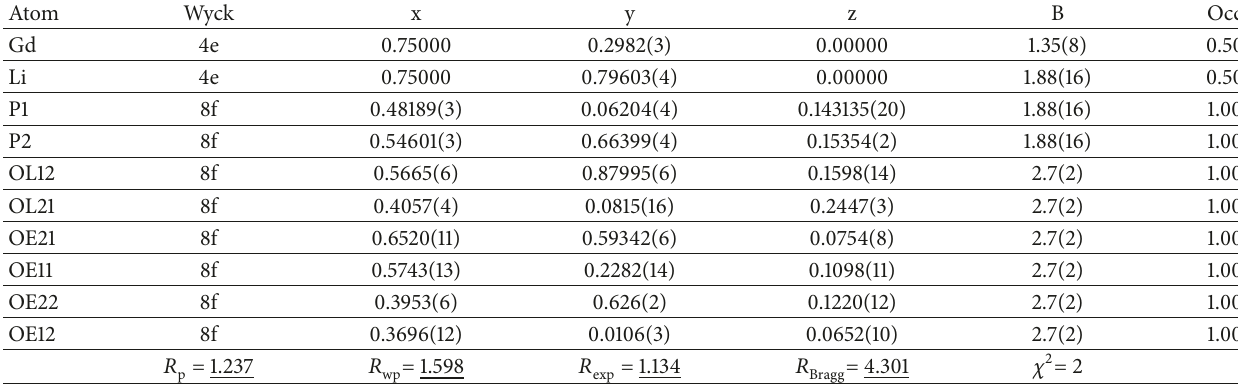
Table 1: Refined structure parameters from powder X-ray Rietveld analysis for LiGd(PO 3 ) 4 in space group I 2/a.